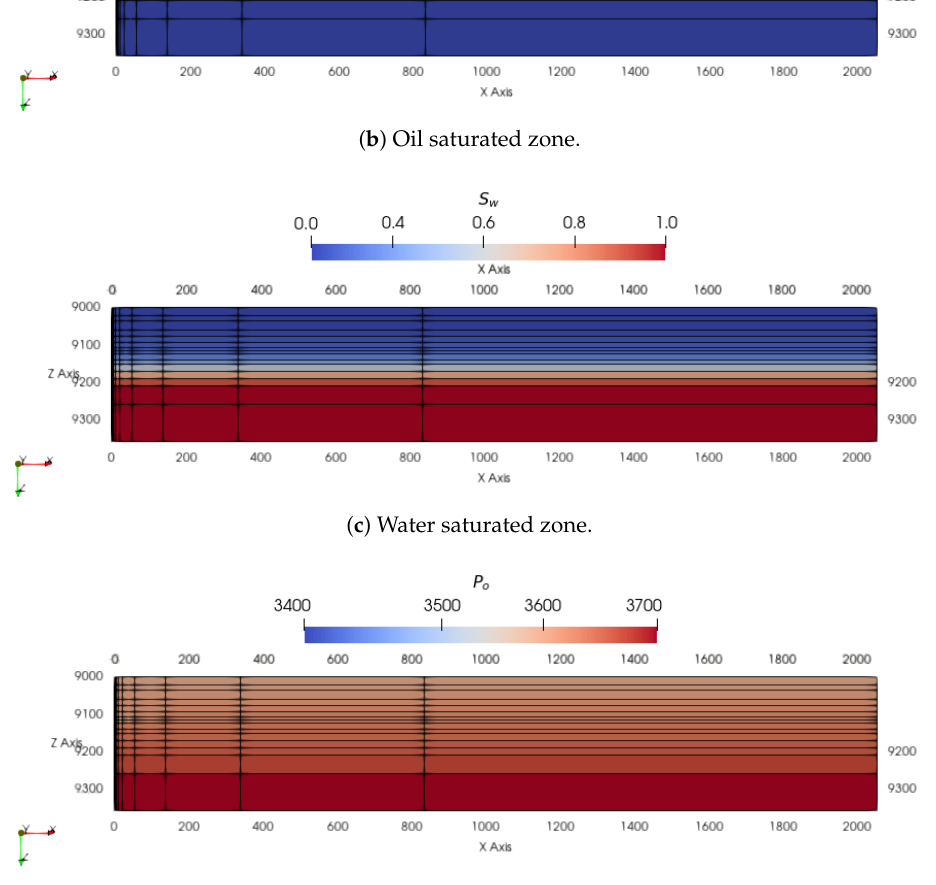
Figure 11. Reservoir initial conditions t 0 , saturations and pressure distribution at gravitational and capillary